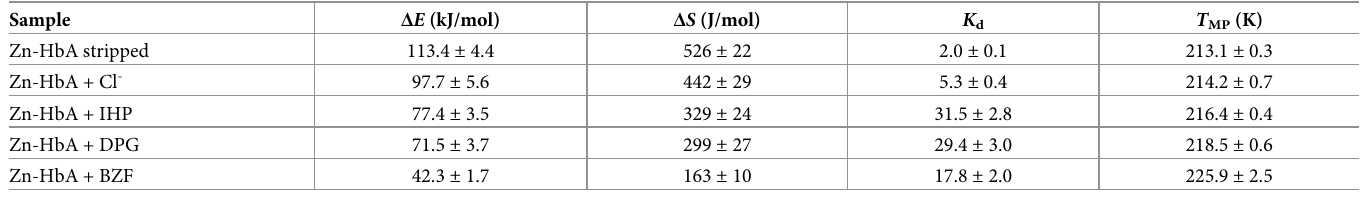
Table 2. Thermodynamic parameters ( ± SD) of the fitting for all kinds of samples (based on our model, see S1 Appendix): Δ E (energy change), Δ S (entropy change), K d (ratio by which the decay process is sped up due to dynamic quenching), T MP (midpoint